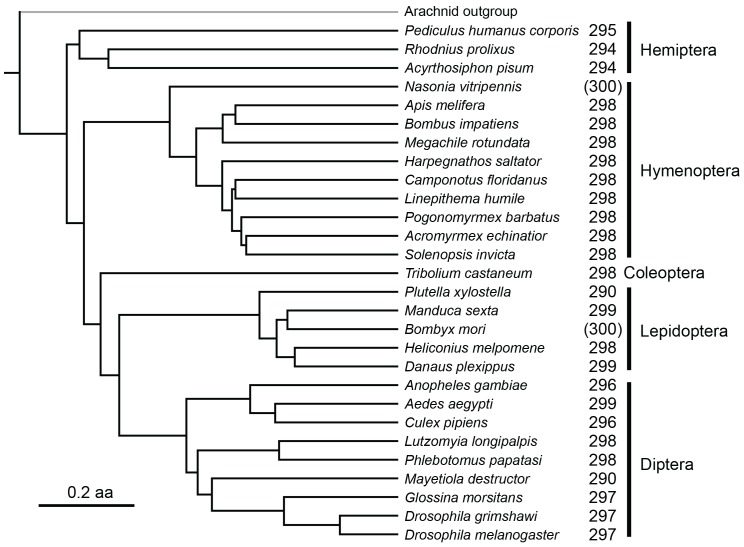
Representation of highly conserved sequences in insect genomes.Phylogenetic tree generated from sequence data using PHYML. Coding regions from Nasonia vittripennis were used as tblastx queries against the Bombyx mori genome assembly to identify highly conserved regions. 300 conserved regions were selected at random and searched for in a broad range of insect genome assemblies using tblastx. In each insect species, 290–299 of these highly conserved regions were found (a rate of 96–99%). Missing sequences are an unknown combination of genomic deletions and incomplete assemblies. With a divergence time of ∼300 MYA between Bombyx and Nasonia, there has been sufficient time for genomic deletions to occur. Branch lengths are based on amino acid divergence between species.